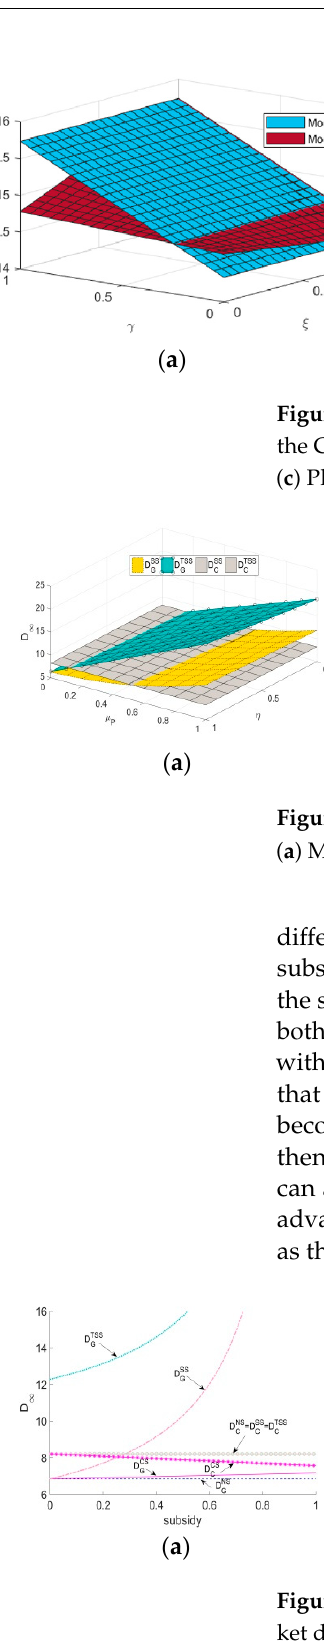
( b ) Figure 6. Effect of the proportion of green consumers λ on the utilities of supply chain members. ( a ) Supplier utility. ( b ) Platform utility. Figure 7 shows the impacts of the influence coefficient of the greenness level on the demand for green agricultural products θ and the environmental concern coefficient of the platform χ on the steady-state utilities of both parties. The more sensitive consumers are to the greenness of green agricultural products, the higher utilities are gained by both parties. Therefore, the supplier and the platform should not only invest more in green R&D and green traceability to improve the greenness level by themselves, but also actively foster the consumers to develop green consumption awareness. For instance, the supplier can promote green agricultural products by means of advertising, media campaigns, and the platform’s DDM capabilities.